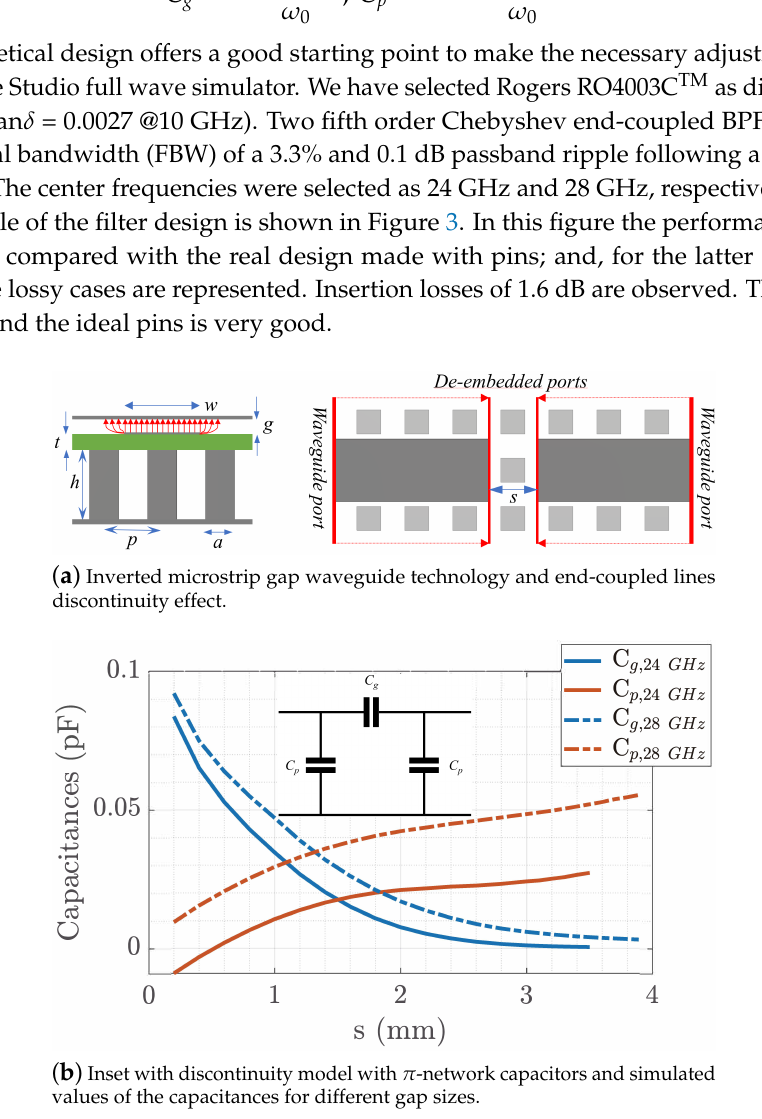
Figure 2. Line geometry and discontinuity